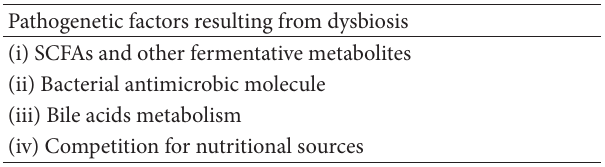
Table 2: This table shows the list of pathogenetic factors generated by